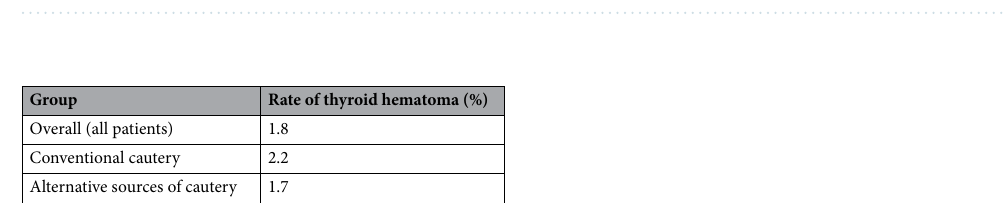
Table 2. Rate of post-operative thyroid hematoma development in all patients and by type of cautery used.